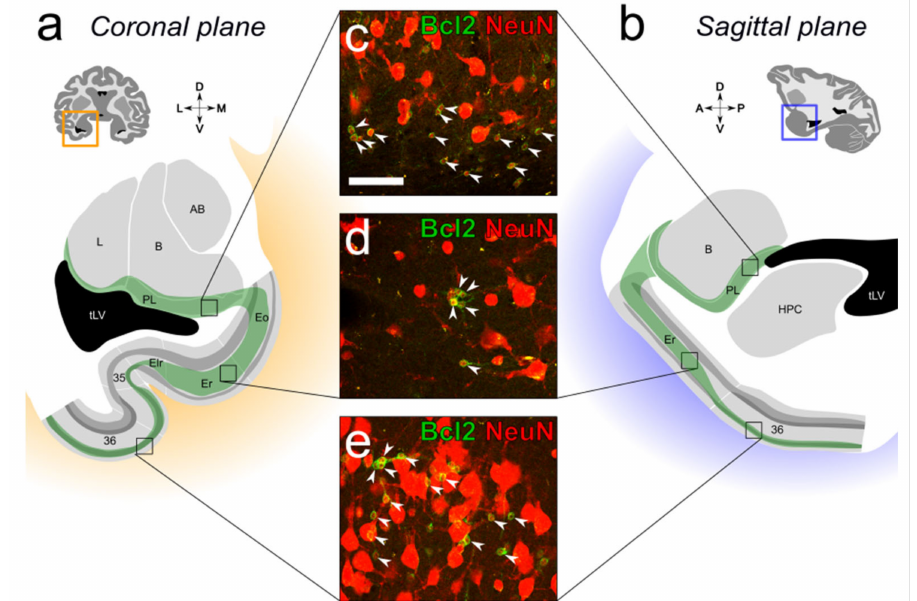
Figure 2. Distribution of Bcl2+/NeuN+ immature neurons in the medial temporal lobe of the adult monkey. The distributions of Bcl2+/NeuN+ immature neurons are represented as green areas on typical coronal ( a ) and sagittal ( b ) sections; ( c ) The largest population of Bcl2+/NeuN+ immature neurons is found in the medial and caudal parts of the paralaminar nucleus lying next to the temporal lobe lateral ventricle; ( d ) Bcl2+/NeuN+ immature neurons are found in the anterior portion of the entorhinal cortex (areas Eo, Er and Elr); ( e ) A large number of Bcl2+/NeuN+ immature neurons is also observed in layer II of the perirhinal cortex (areas 35 and 36). Abbreviations: B, basal nucleus; L, lateral nucleus; AB, accessory basal nucleus; HPC, hippocampus; PL, paralaminar nucleus; tLV, temporal lobe lateral ventricle. Scale bar in ( c ) = 50 µ M, applies to panels ( d , e